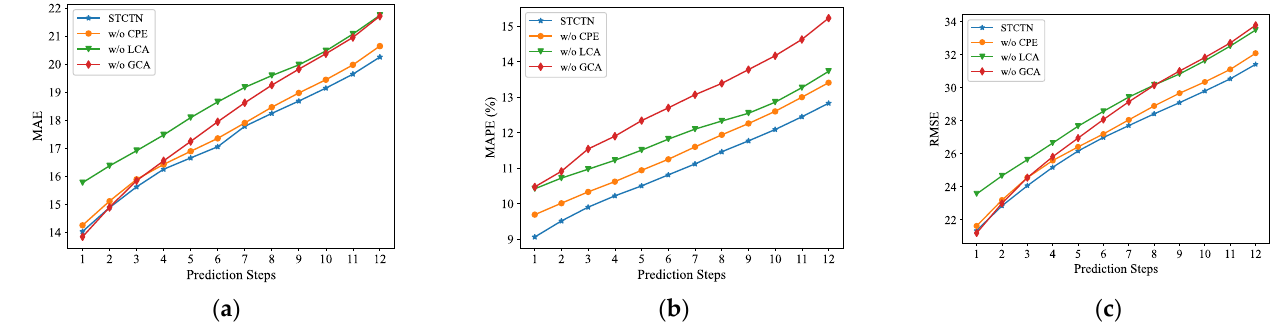
Figure 7. Errors in each prediction step of STCTN and the three variants. ( a ) MAE; ( b ) MAPE; ( c ) RMSE.